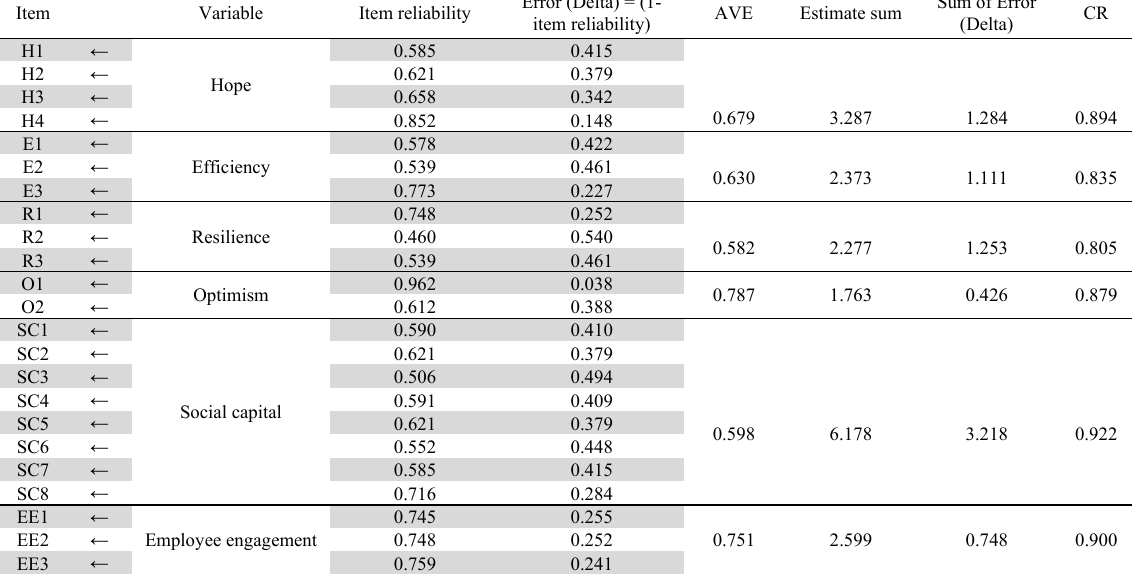
Convergent Validity: Standardized Regression Weights: (Group number 1 - Default